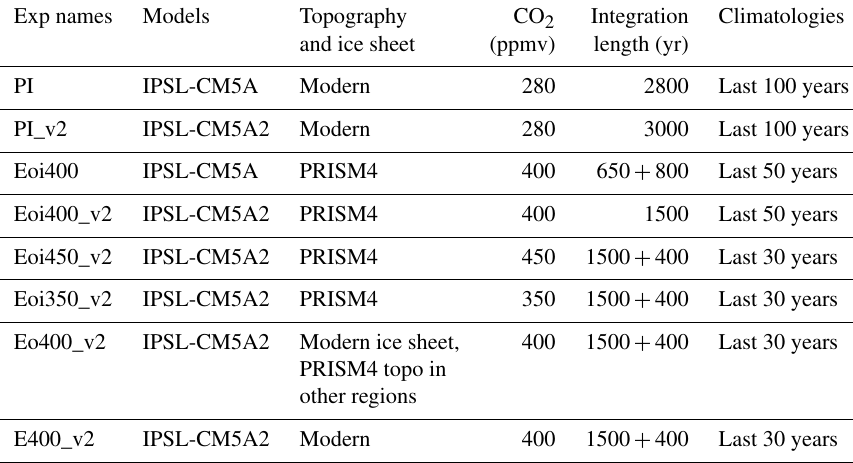
Table 2. Details of experimental settings.